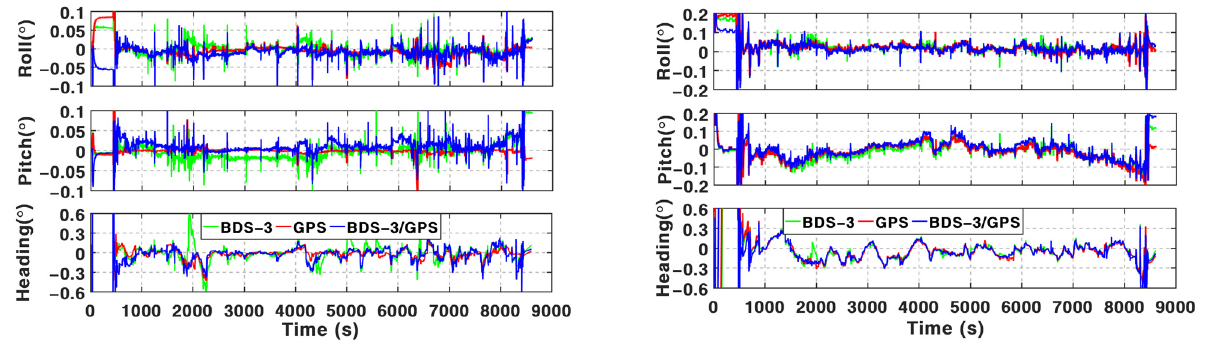
Figure 18. Attitude errors of BSSD PPP/INS TCI ( left ) and BSSD PPP/INS/ODO TCI ( right ) with different GNSS. Table 6. Attitude RMS of BSSD PPP/INS TCI with and without odometer aid.